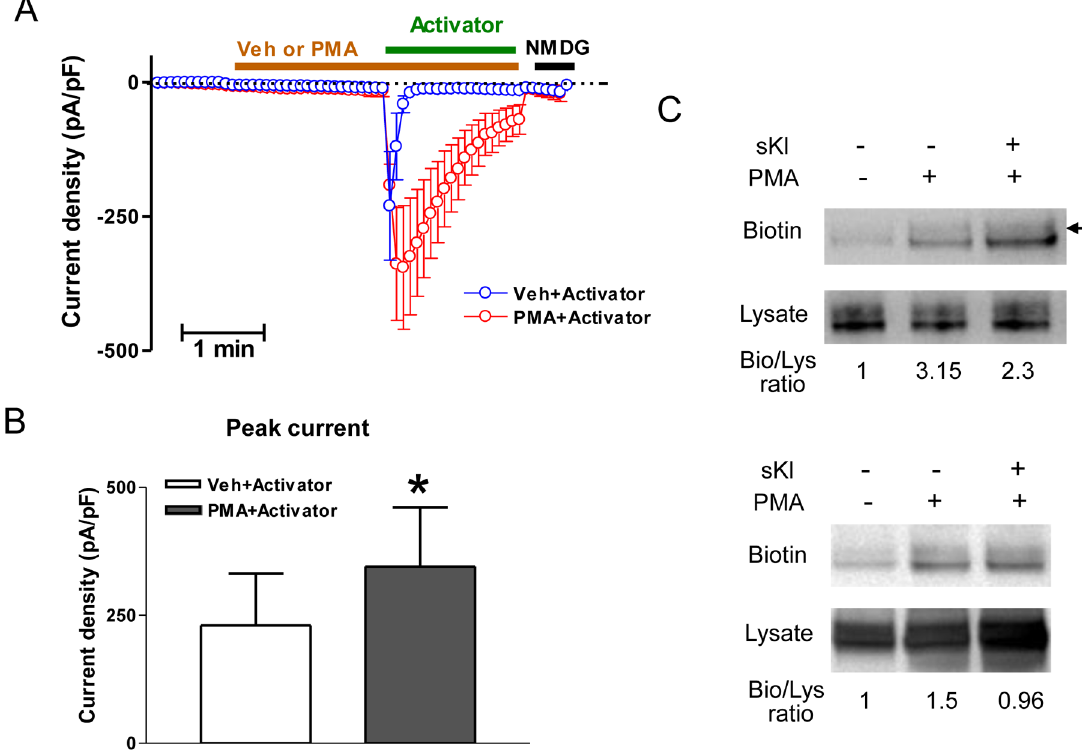
Fig 5. Additional evidence supporting that DAG stimulates TRPC6 exocytosis acting at Munc13. (A) Effect of PMA vs vehicle on TRPC6 activated by BIRA0411XX. HEK cells expressing TRPC6 were treated with PMA or vehicle (DMSO) for ~2 min before application of BIRA0411XX (labeled as “activator”). (B) Mean ± SEM of peak inward current density of experiments performed in panel A. (C) PMA increases cell-surface expression of TRPC6, which is inhibited by sKlotho. Cell surface abundance of Flag-tagged TRPC6 expression in HEK cells were analyzed by biotinylation. Abundance of biotinylated TRPC6 protein detected by anti-Flag antibody (labeled “Biotin”; analyzed by densitometry) was divided by the total TRPC6 abundance in lysates (labeled “Lysate”), and the ratios (labeled “Bio/Lys ratio”) were normalized to the setting without PMA, without sKlotho (first lane from left). Shown are two separate experiments with similar results. Numerical values indicate normalized ratios. Arrow indicates glycosylated TRPC6. Please notes that gycosylation is normally heterogenous that may occur in only 1 or 2 subunits of tetrameric channels such as TRPC6.